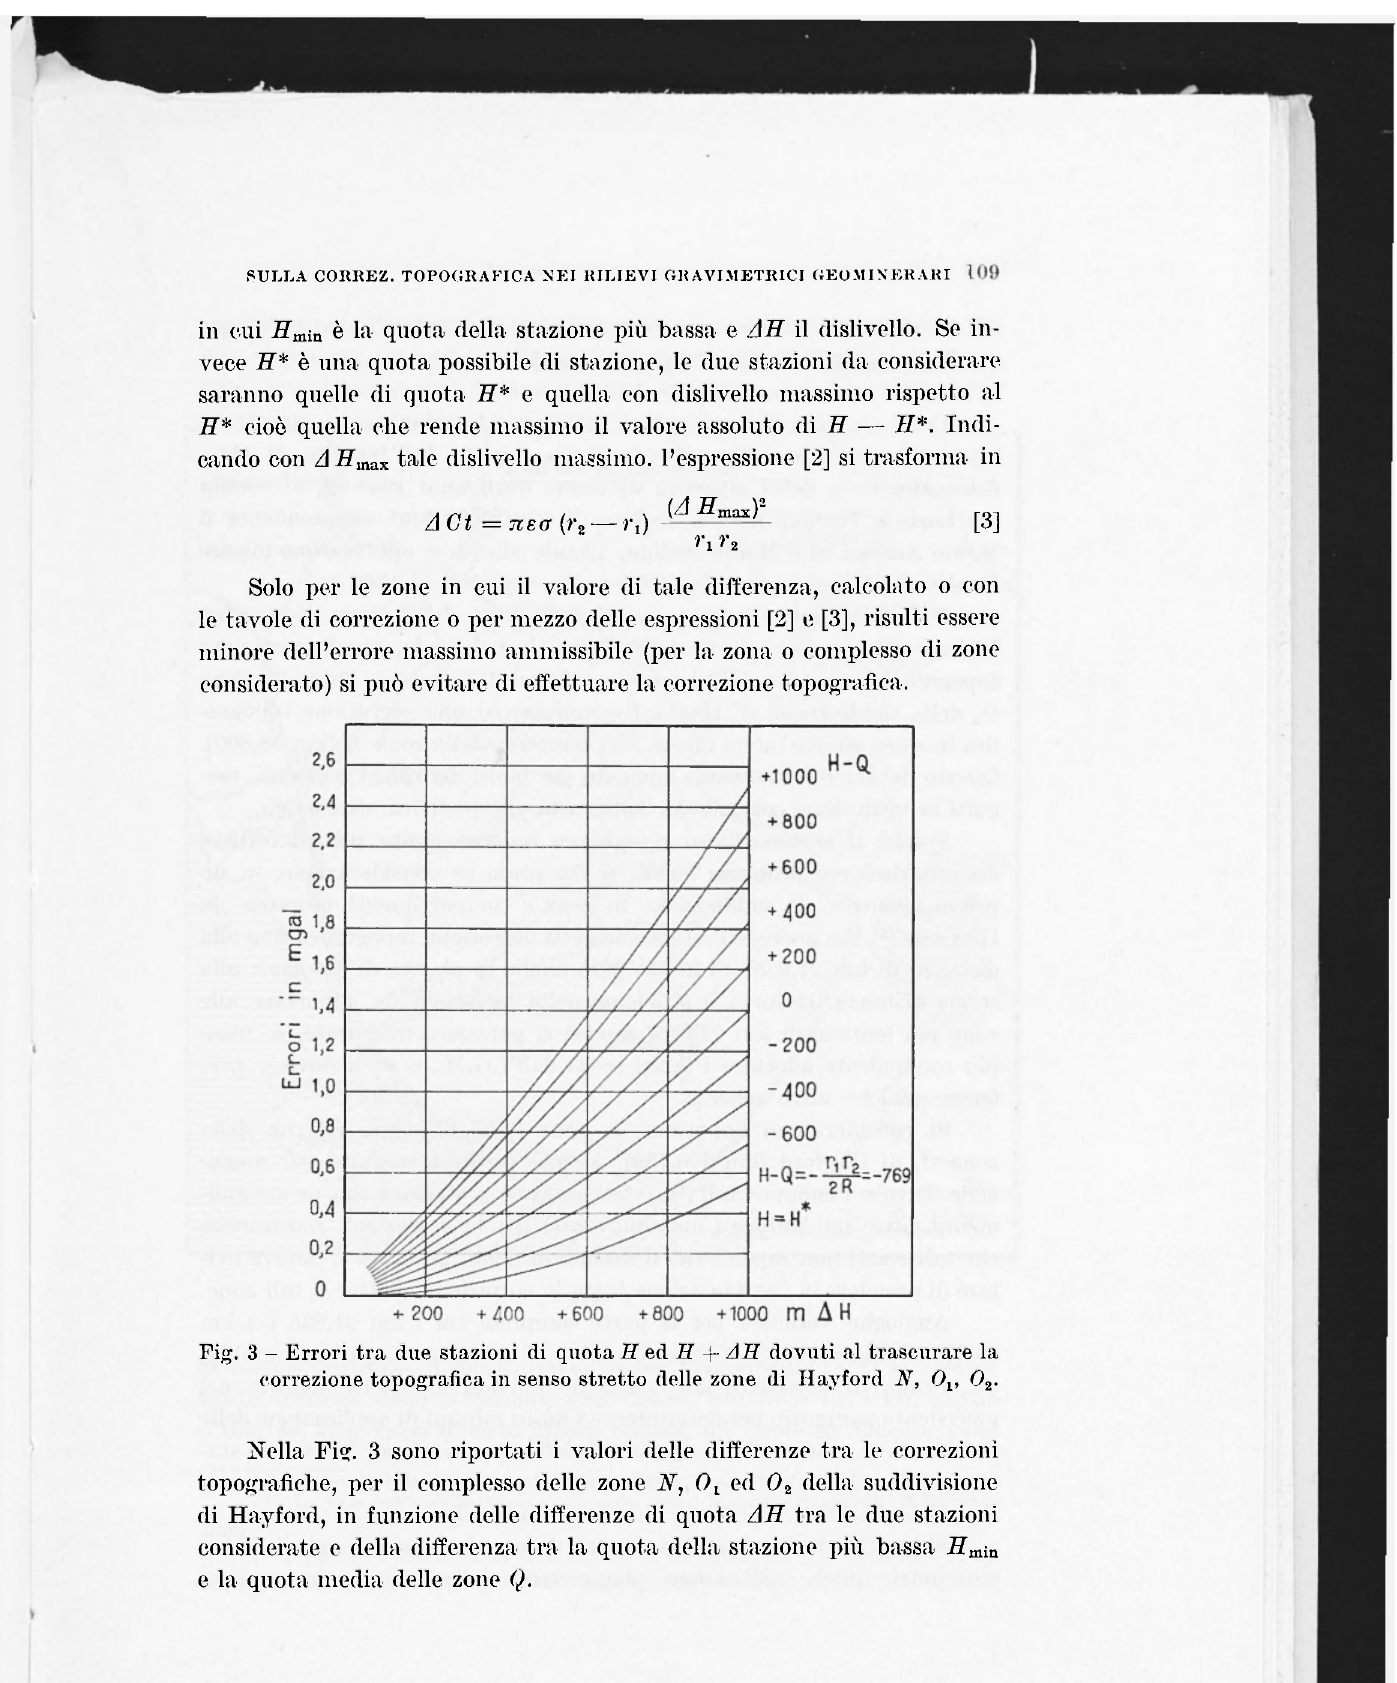
Fig. 3 - Errori tra due stazioni di quota H ed H + AH dovuti al trascurare la correzione topografica in senso stretto delle zone di Iiayford N, O V 0 2 . Nella Fig. 3 sono riportati i valori delle differenze tra le correzioni topografiche, per il complesso delle zone N, O l ed 0 2 della suddivisione di Hayford, in funzione delle differenze di quota AH tra le due stazioni considerate e della differenza tra la quota della stazione più bassa H min e la quota media delle zone